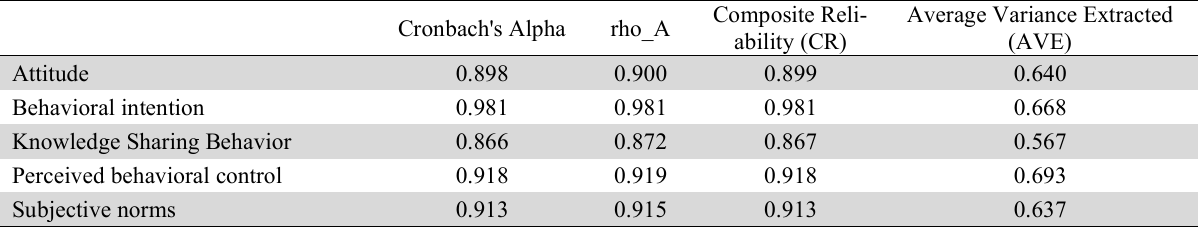
Construct Reliability and